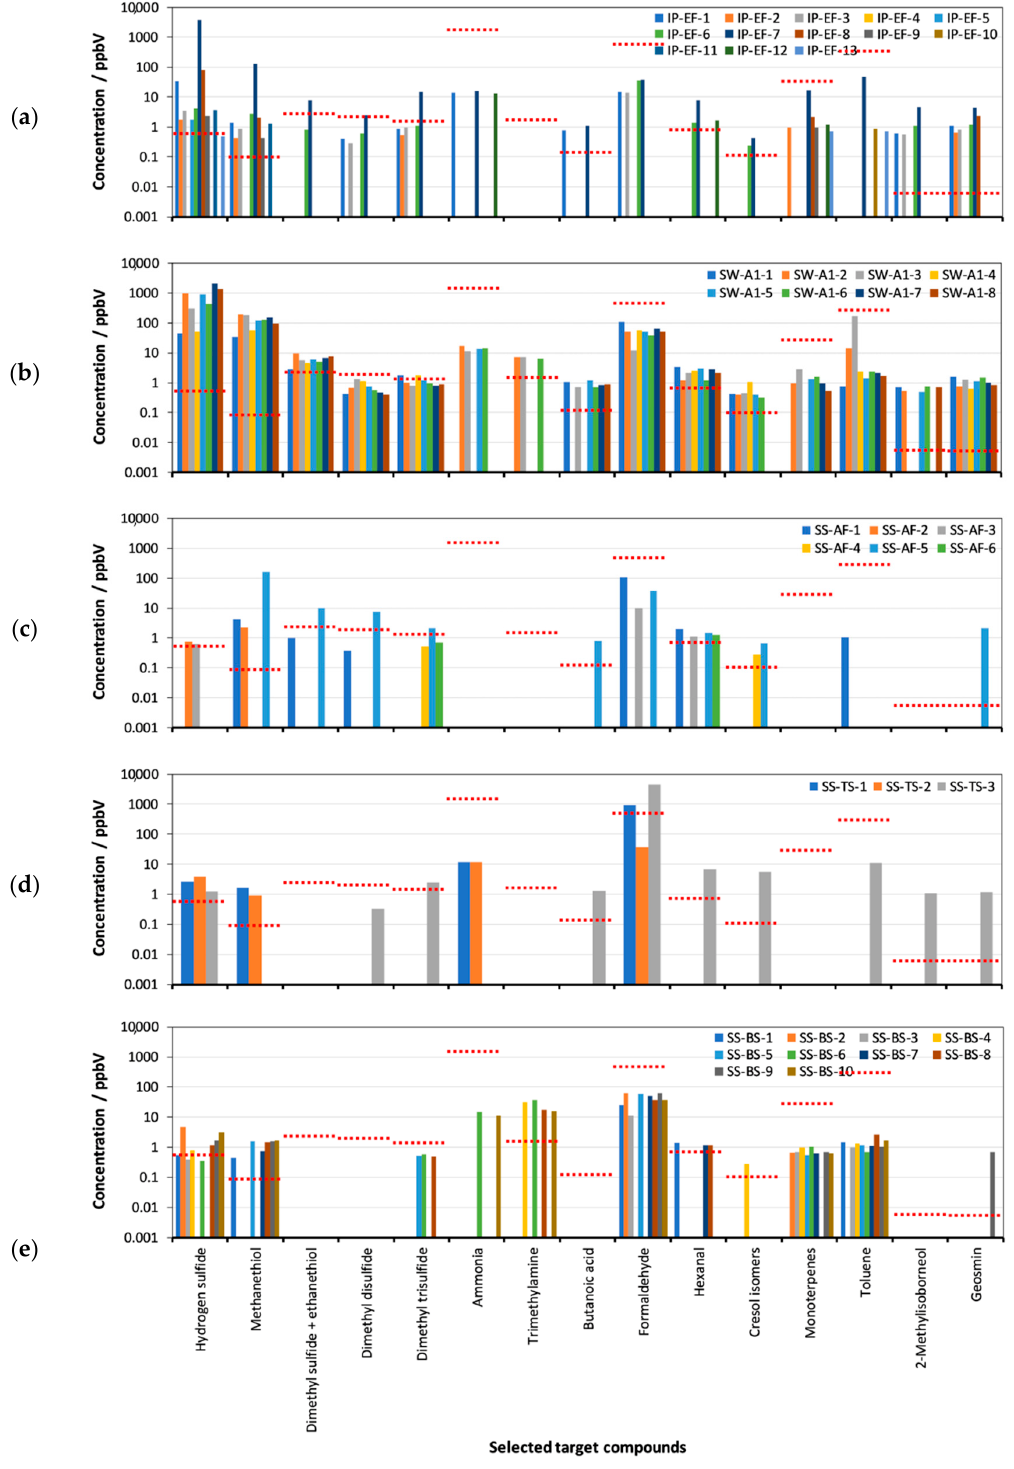
Figure 3. SIFT-MS concentration data (in ppbV on a logarithmic scale) for more significant odorants from a variety of odor sources: ( a ) influent biofilters, ( b ) reactor aerobic–location 1, ( c ) dissolved air flotation, ( d ) gas turbine stacks, and ( e ) biofilter at the biosolids storage location. ODTs are indicated approximately with dotted red lines.